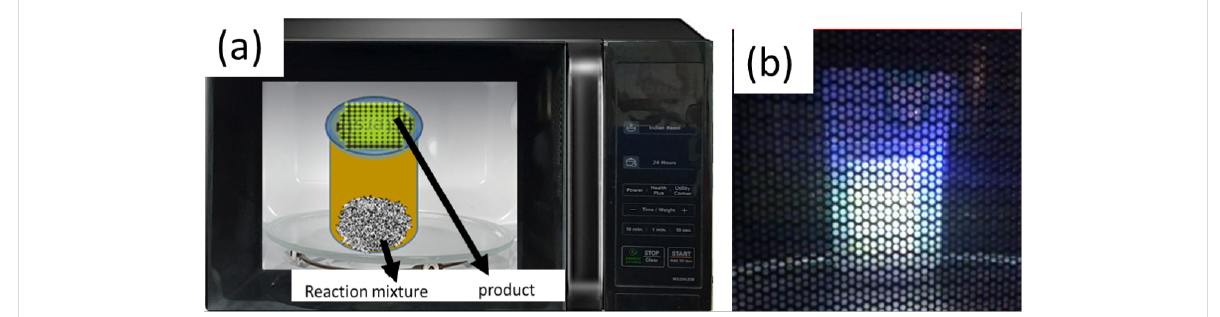
Figure 2: (a) Schematic of the synthesis in a microwave reactor, (b) plasma generated with metal particles under microwave irradiation.